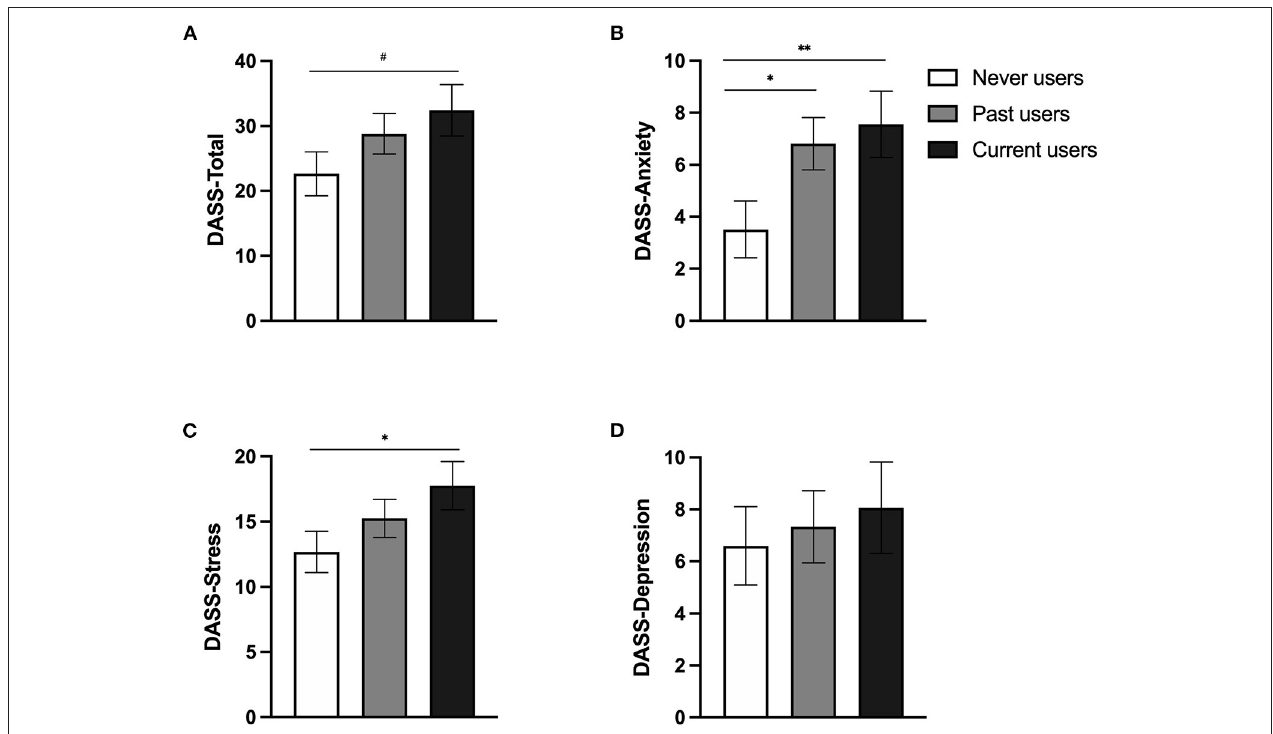
FIGURE 4 | Symptoms of depression, anxiety, and stress (measured by the DASS-21) of current hormonal contraceptive (HC) users, past users, and never users during the COVID-19 pandemic. (A) Mean general distress. (B) Mean anxiety symptoms. (C) Mean stress symptoms. (D) Mean depressive symptoms. Never users, past users, and current users are illustrated by white, gray, and black bars, respectively. Error bars represent standard error. # < 0.08, * p < 0.05, ** p < 0.01.